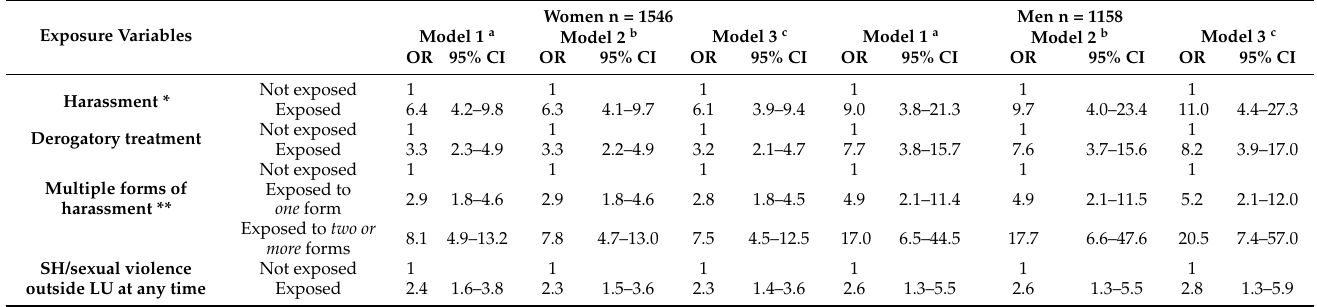
Table 6. Association between exposure to harassment *, derogatory treatment, experience of SH/sexual violence outside of Lund University and sexual harassment at Lund University, by gender. Odds ratios and 95% confidence intervals presented for three different multivariable logistic regression models. Women n = 1546, Men n =